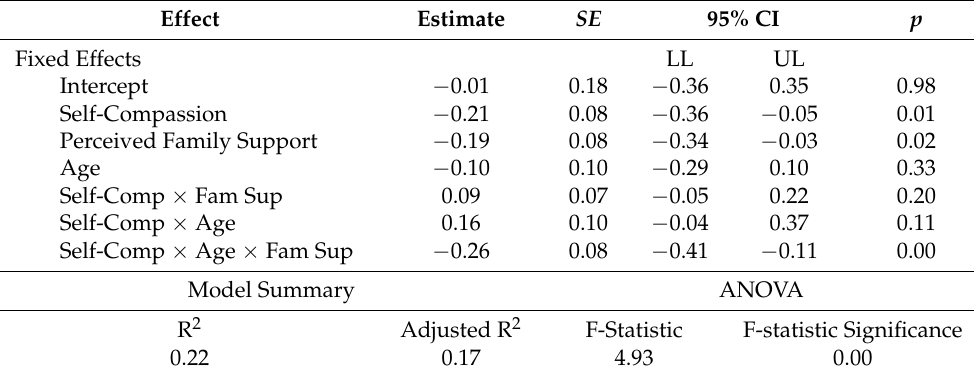
Table 3. Regression results with depressive symptoms as the outcome.